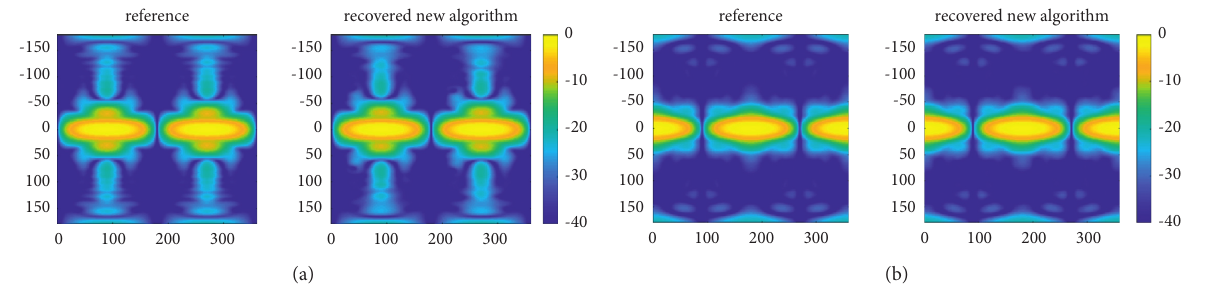
and E of horn antenna by adopting the proposed algorithm. (a) E θ φ